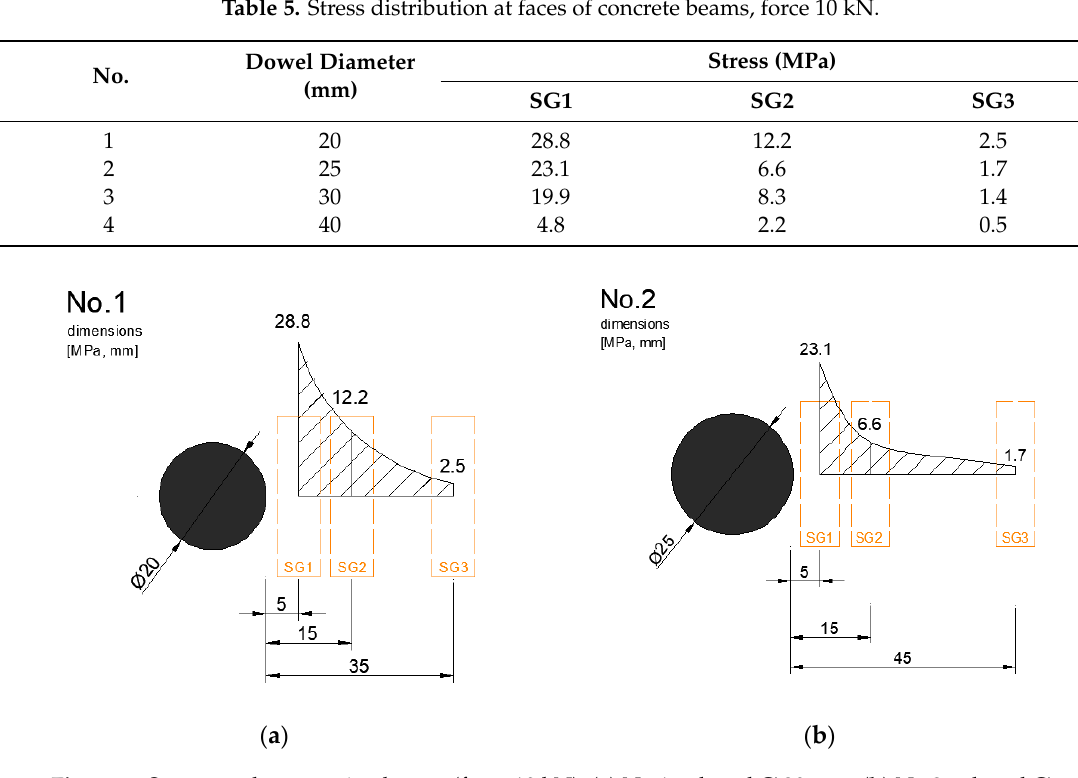
Figure 9. Stress results on testing beams (force 10 kN): ( a ) No.1—dowel Ø 20 mm; ( b ) No.2—dowel Ø 25 mm.